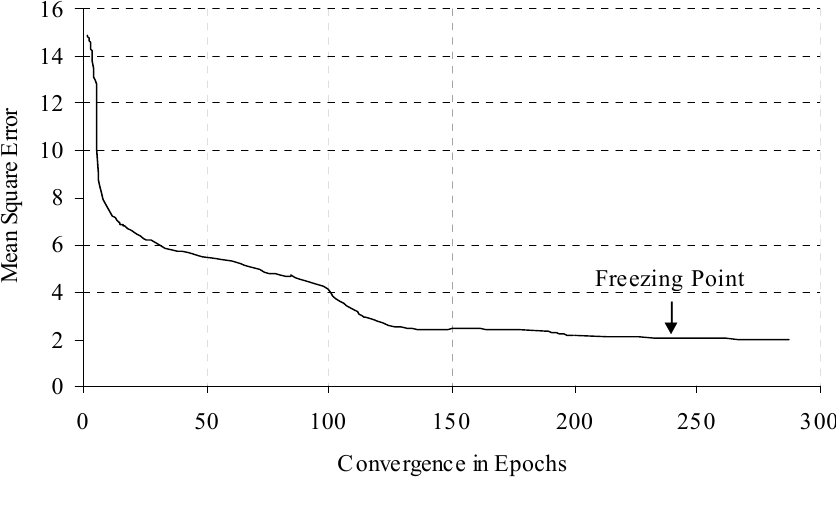
Figure 8. Training time error for the diabetes data with weight freezing.